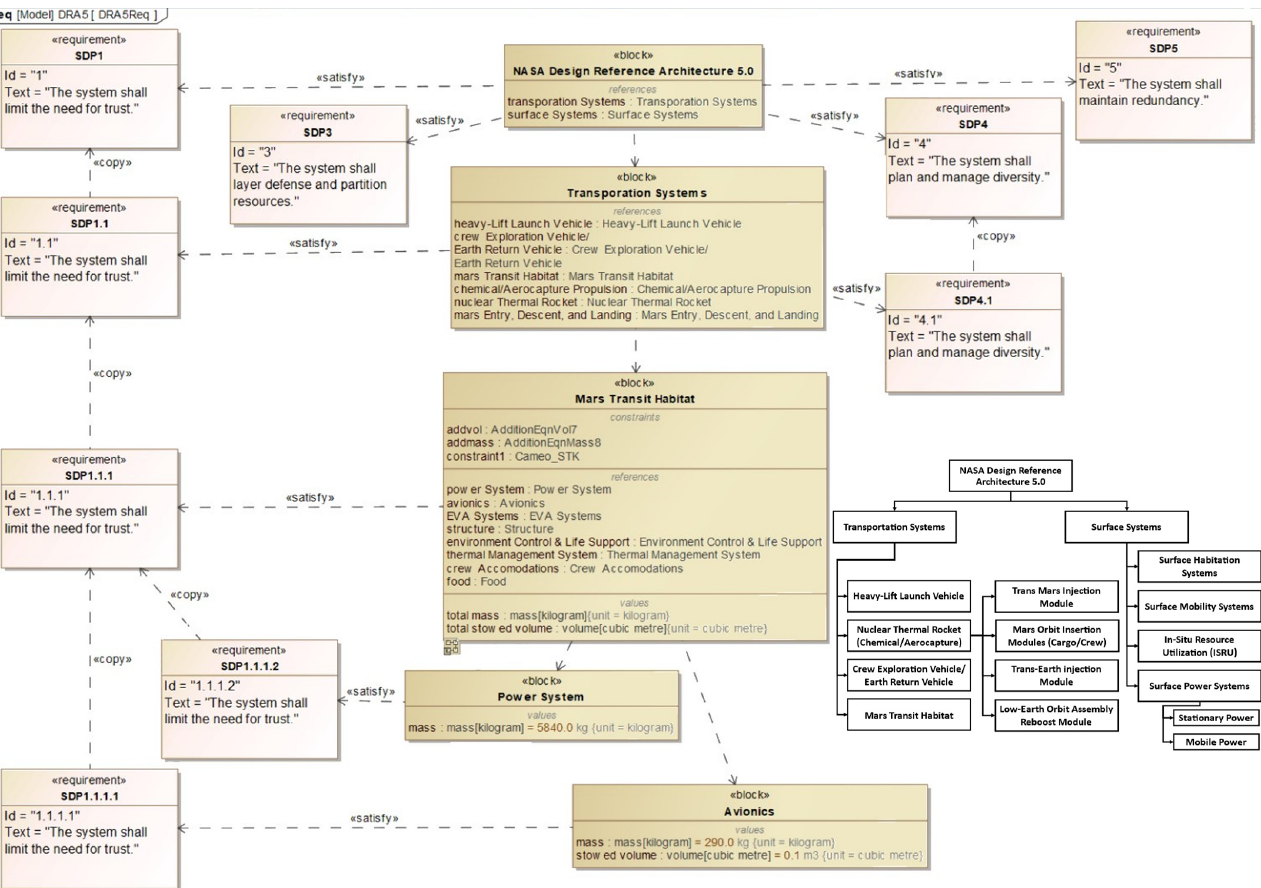
Figure 4. Dassault Cameo SysML requirements diagram showing cyber ‐ resilient structural design principle (SDP) requirements satisfied by different levels of architectural hierarchy in a crewed Mars mission plan comprised of heterogenous cyberphysical systems. This builds upon previous work on holistic modeling for complex space missions and serves as a proof of concept for developing more complex models. The diagram on the bottom right of the figure shows a top ‐ level breakdown of the NASA Mars Design Reference Architecture 5.0 modeled in this example [28]. SDP requirements stem from NIST 800 ‐ 160 Vol. 2 Table D ‐ 15, shown in Table 4 [22].